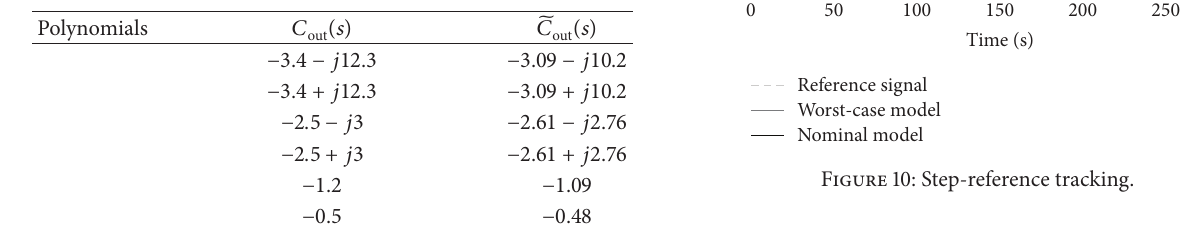
Table 8: Polynomials 𝐶